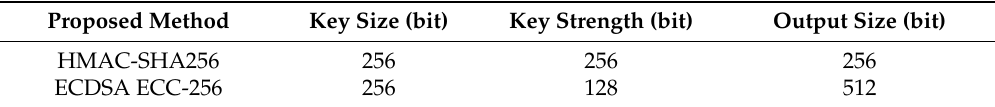
Table 5. Analysis of the security strength and additional size for message m.